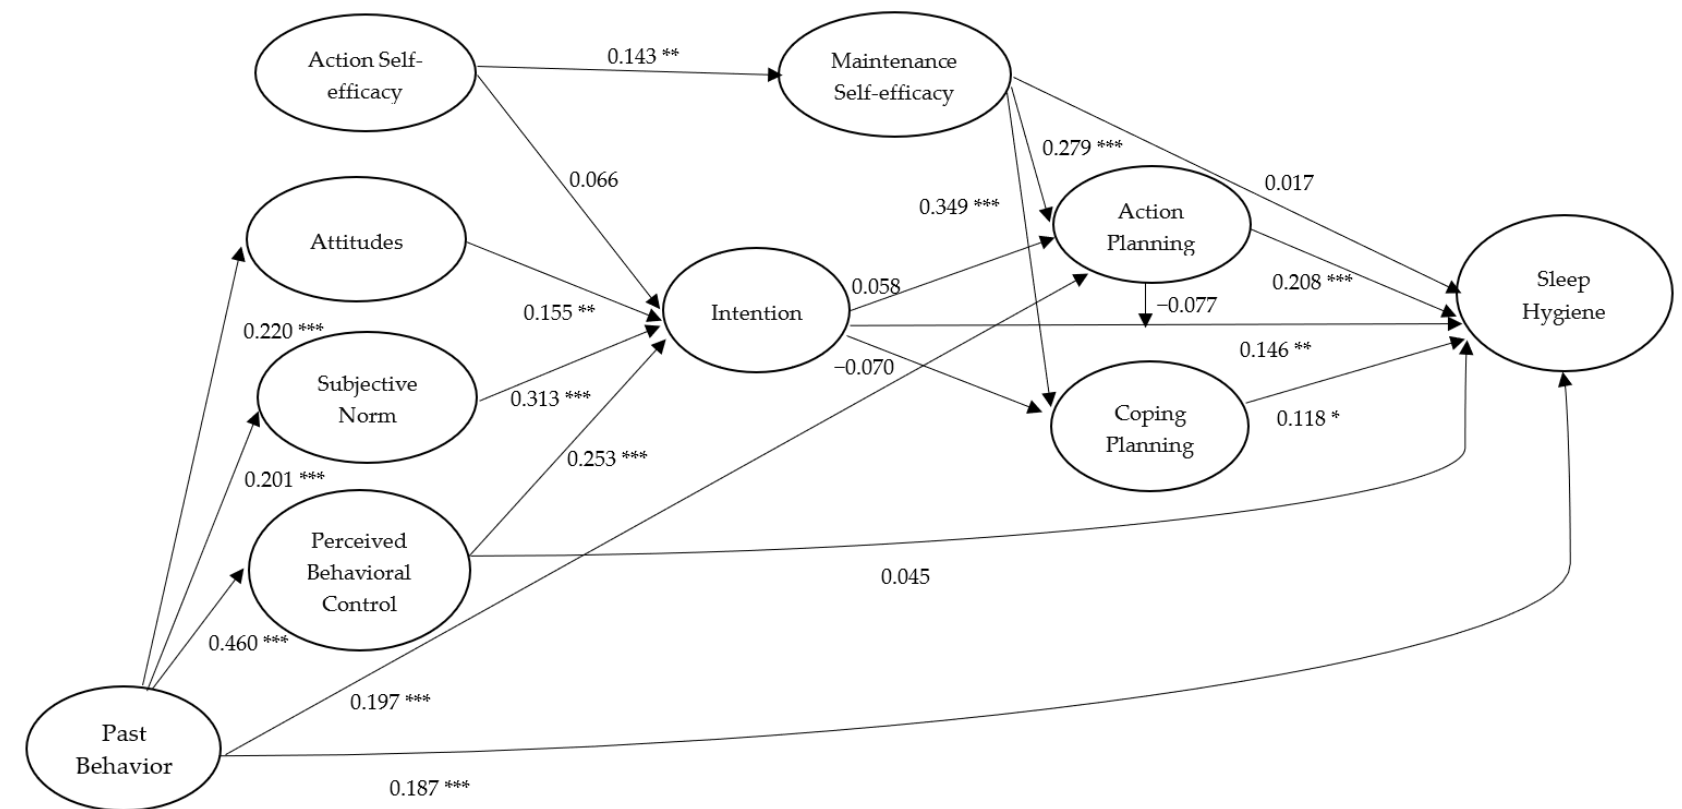
Figure 5. Standardized path coefficients of the Integrated Social-Cognition Model for sleep hygiene including past behavior. Note. College students’ age and gender were controlled. All hypothesized effects among the psychological and behavioral variables were proposed to be positive in direction. Only significant effects from past behavior to psychological variables were displayed. * p < 0.05; ** p < 0.01; *** p < 0.001.